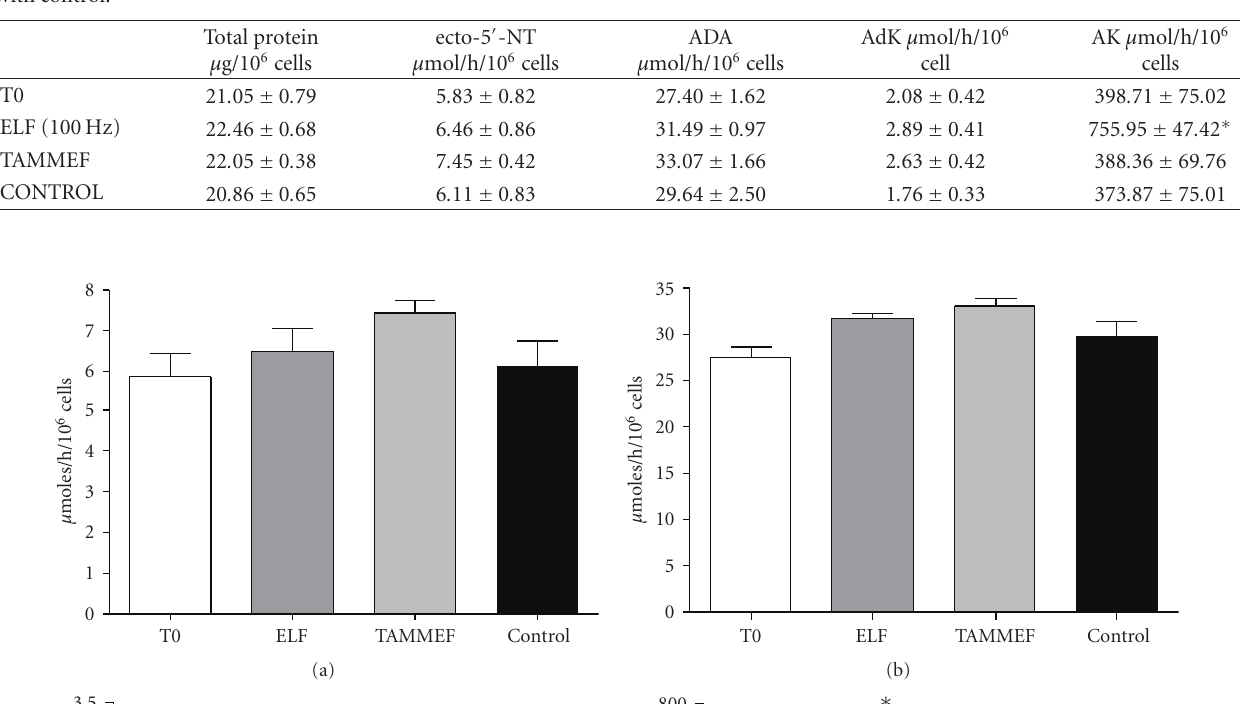
Table 1: Total protein content and activities of enzymes involved in purine metabolism in human PBMCs for T0 cells, control cells, and cells treated with ELF EMFs and TAMMEFs. Data is shown as the mean ± SD of five independent experiments, ∗ P < .05 compared with T0 and with control.